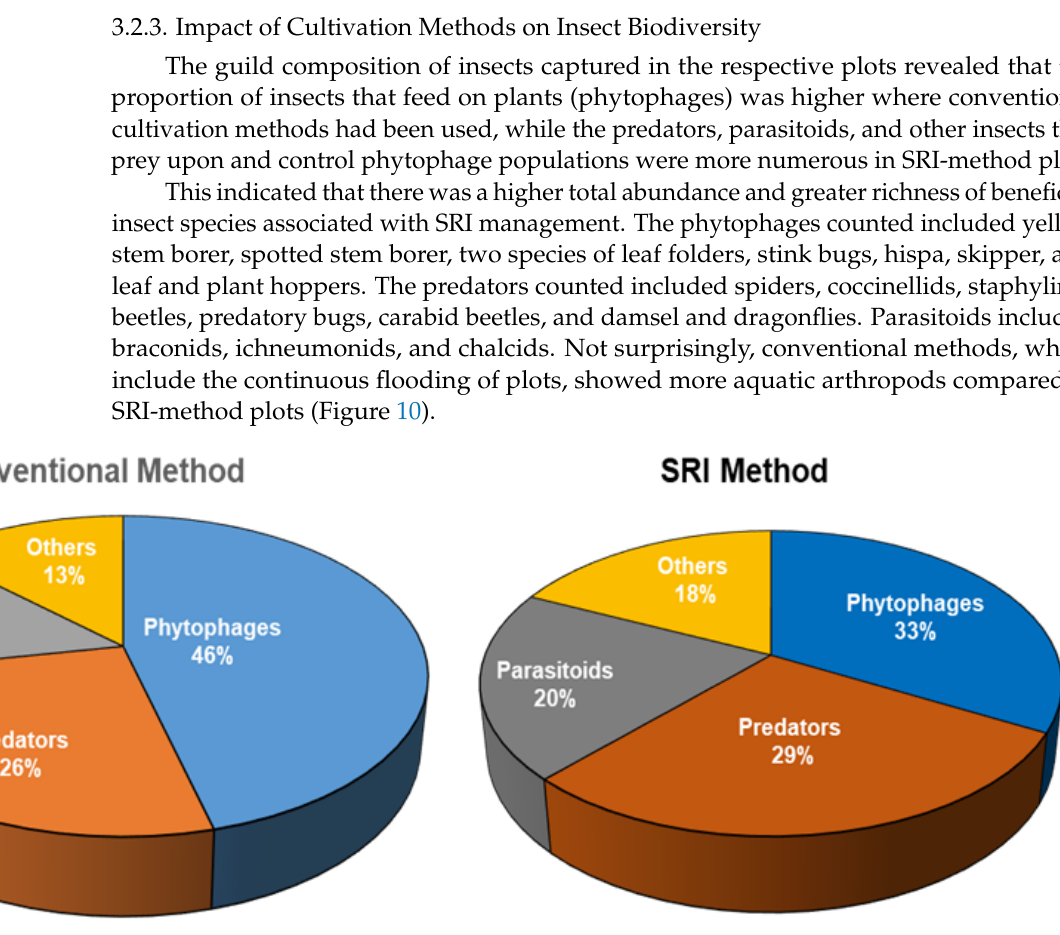
Figure 10. Guild composition of arthropods with conventional and SRI methods of rice cultivation.